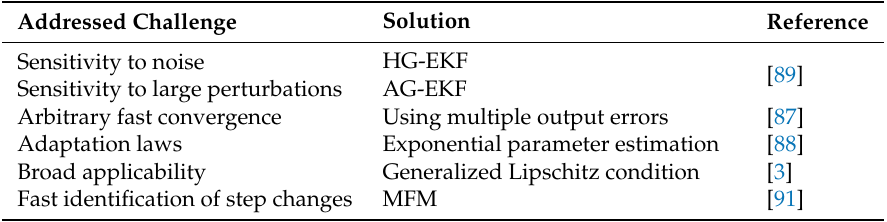
Table 2. Adaptive observer addressed challenges and solutions to increase convergence